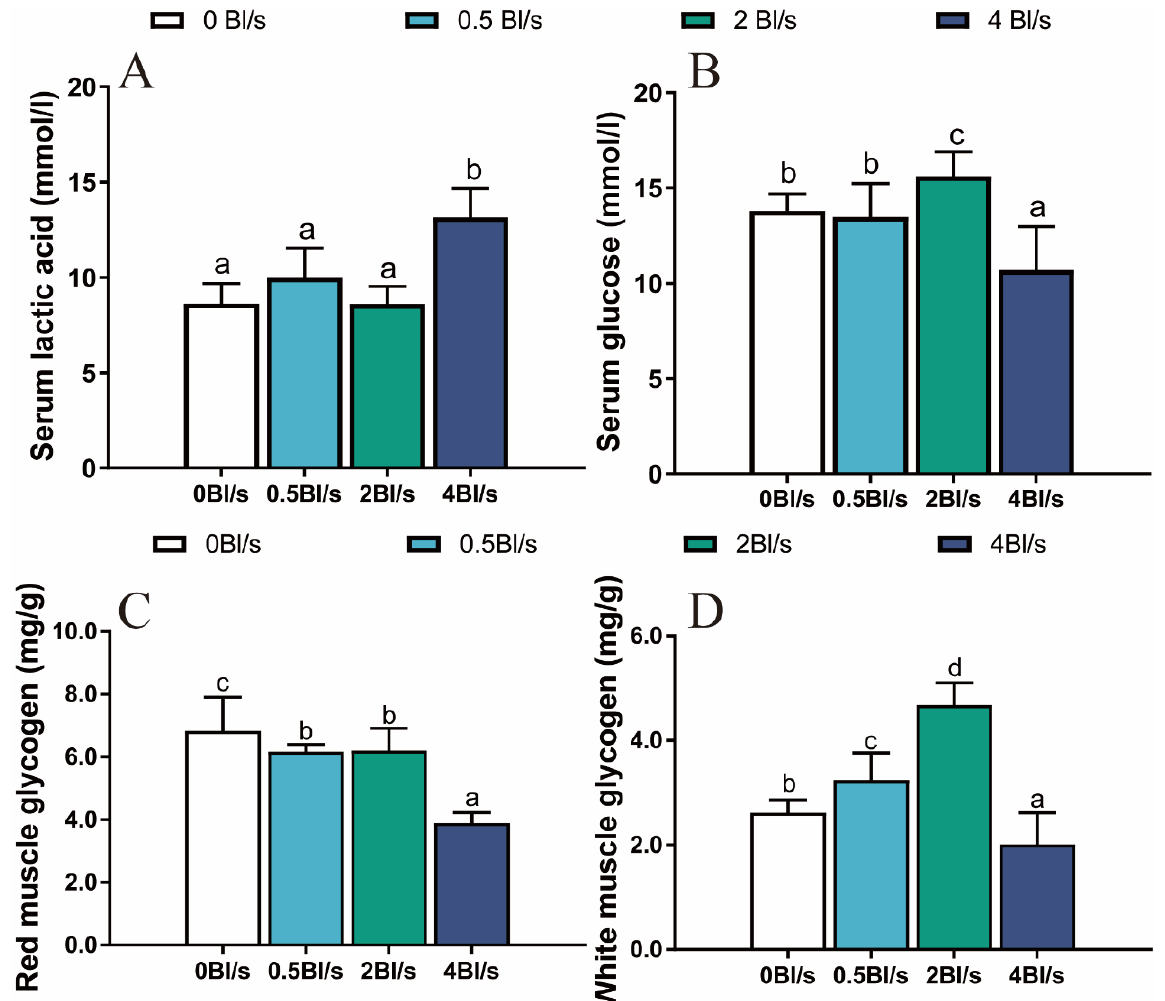
Figure 3. Effect of water velocity on lactic acid ( A ), glucose ( B ), glycogen of red muscle ( C ), glycogen of white muscle ( D ) in grass carp. Data are means ± SEM (n = 9 fish per treatment). Different letters indicate significant differences between treatments ( p < 0.05).